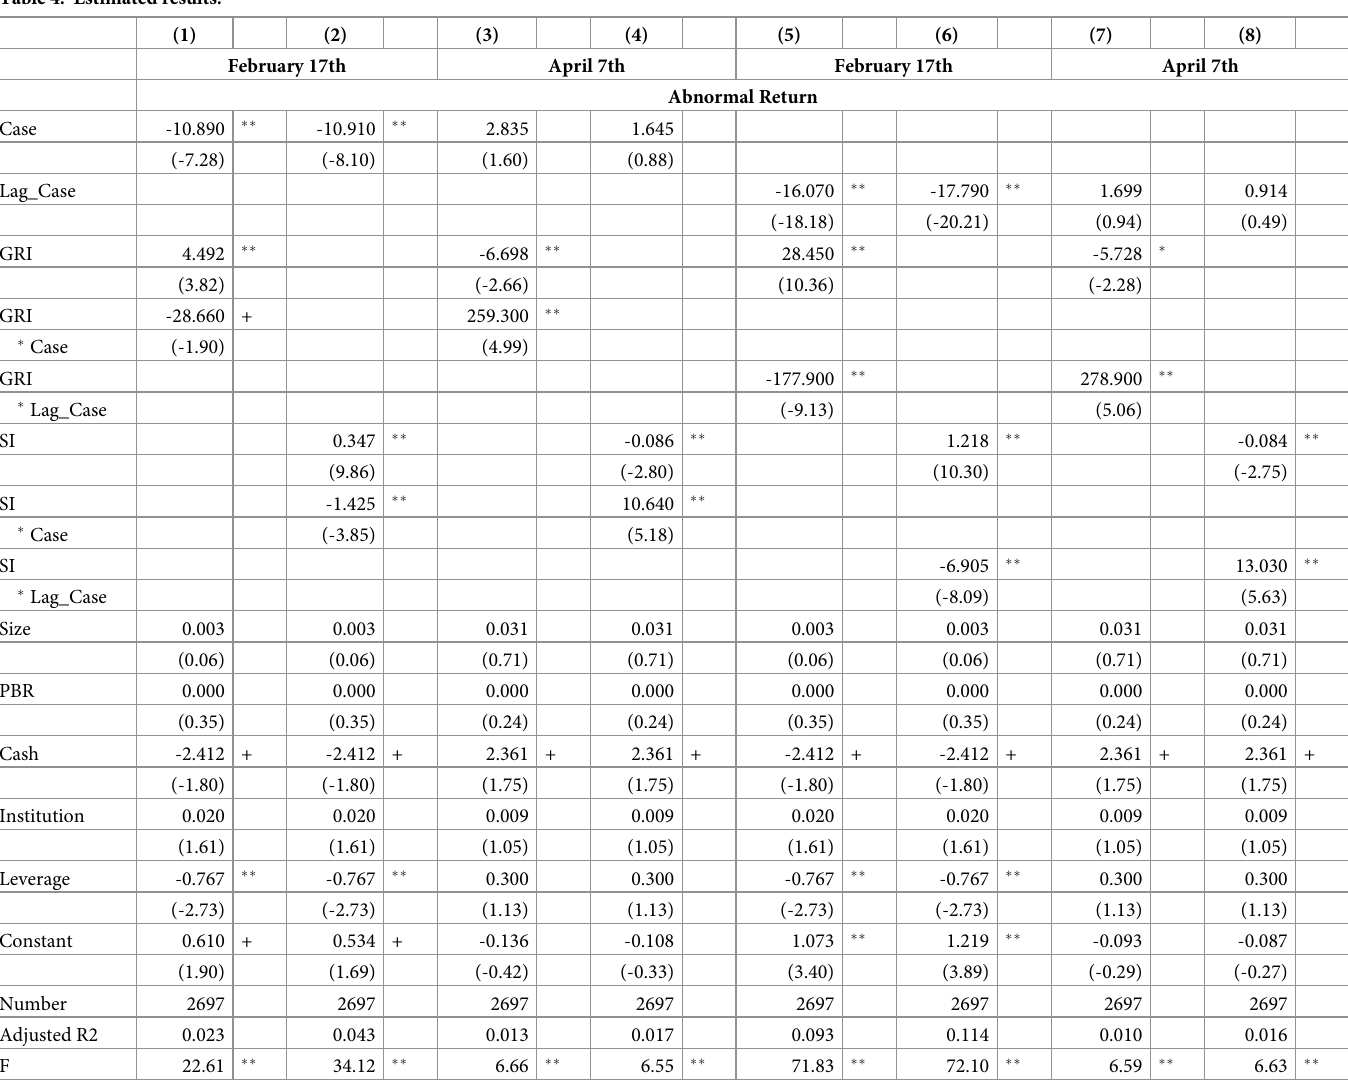
Table 4. Estimated